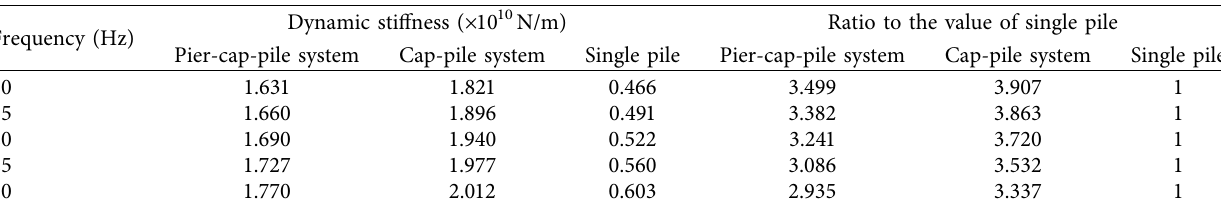
Figure 11: Comparison of the dynamic stiffness of three-step test results. Table 1: Values of dynamic stiffness at different